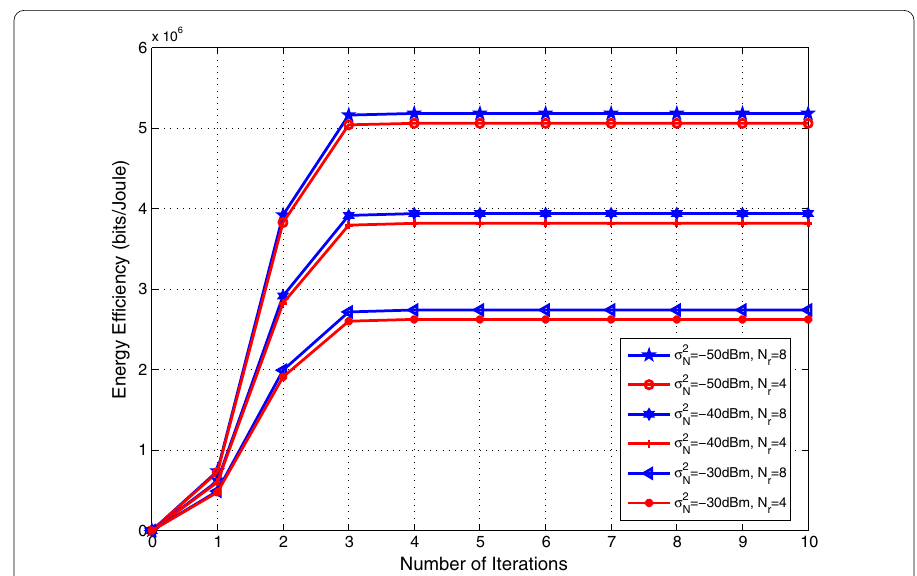
Fig. 3 Convergence performance of EESRA for σ 2 N = − 50dBm, − 40dBm, − 30dBm , and N r = 4,8